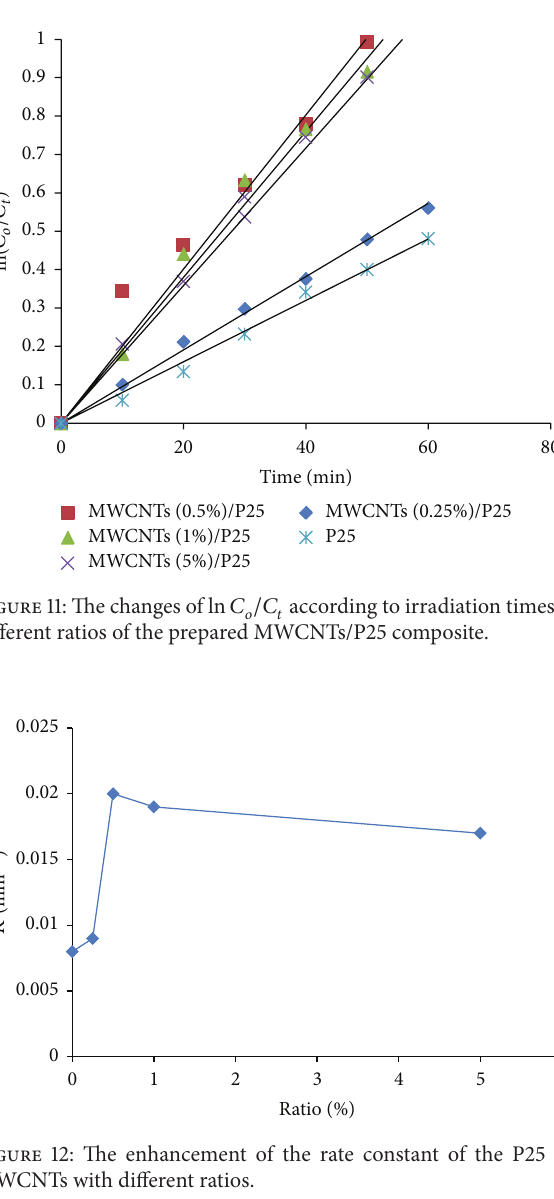
Figure 10: The photocatalytic decolorization percentage of the BBR dye at different ratios of the prepared MWCNTs/P25 composite.